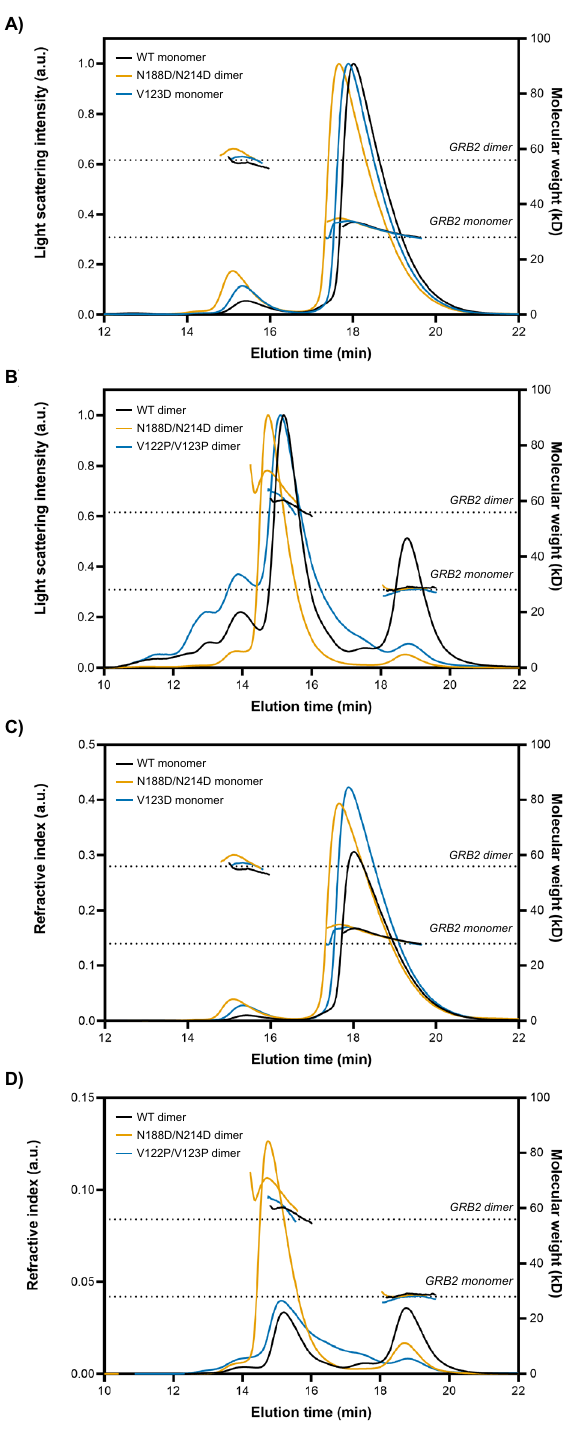
Figure 3. SEC-MALS analysis of GRB2 mutants. Overlays of GRB2 WT, N188D/N214D, and V123D monomers are shown in black, orange, and blue, respectively, with ( A ) light scattering or ( C ) refractive index plotted against elution time. Overlays of GRB2 WT, N188D/N214D, and V122P/V123P dimers are shown in black, orange, and blue, respectively, with ( B ) light scattering or ( D ) refractive index plotted against elution time. Dashed lines denote the expected molecular weights of GRB2 monomer (~ 28 kDa) and dimer (~ 56